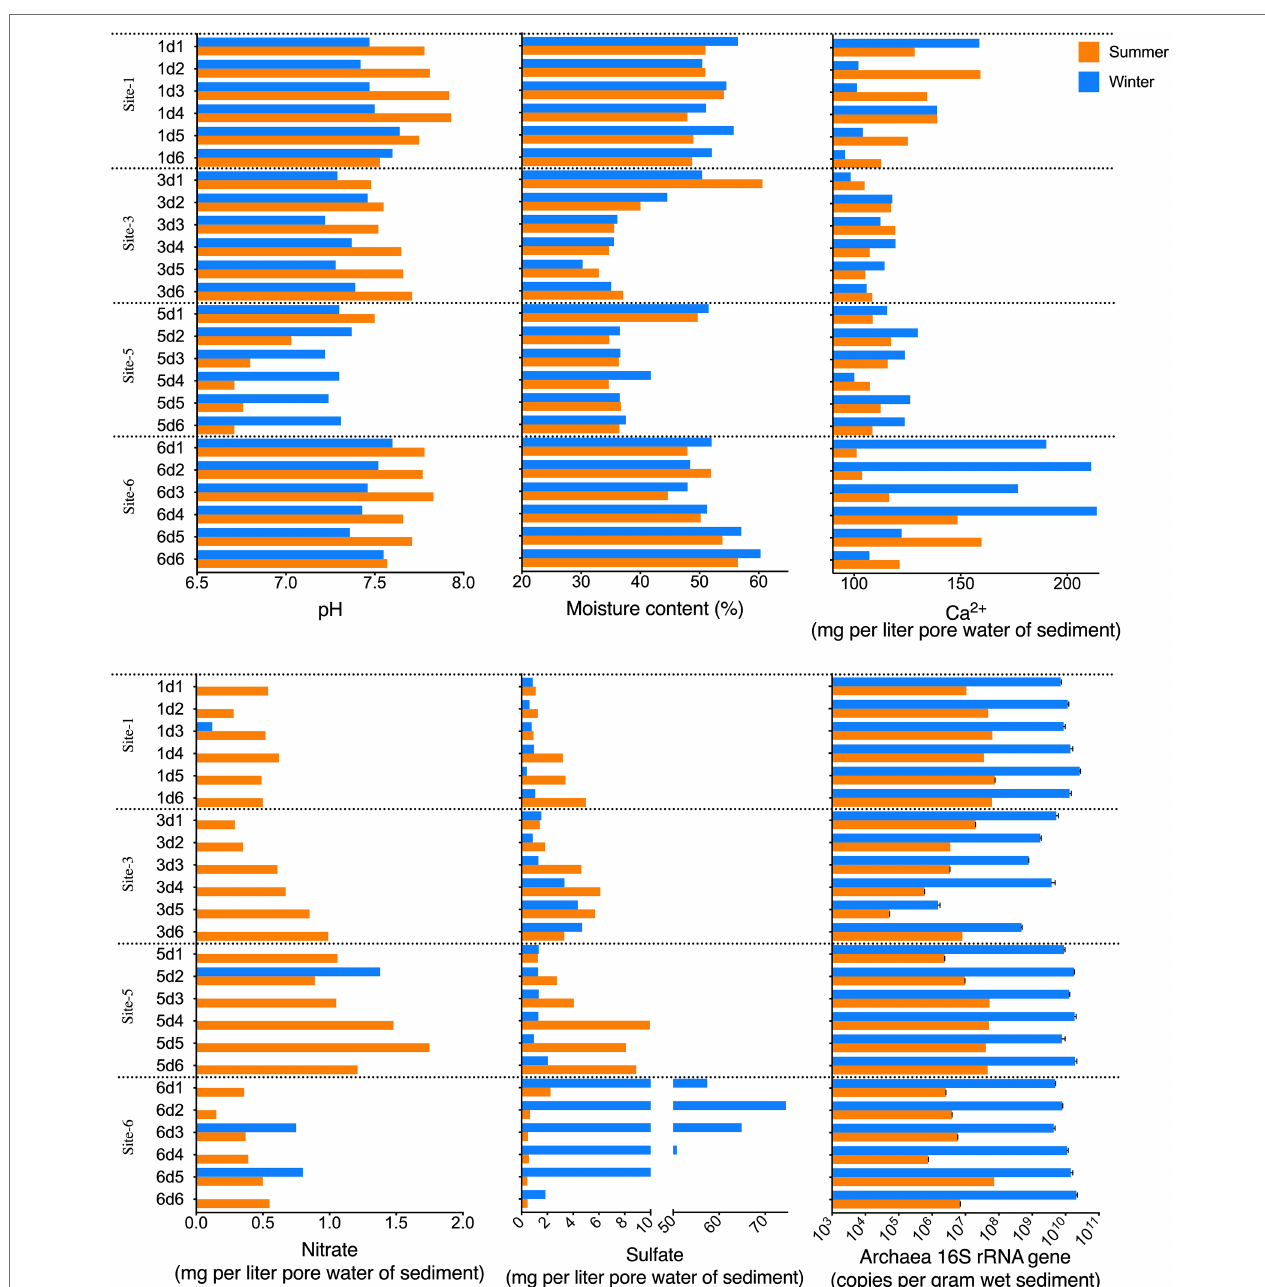
FIGURE 2 | Physicochemical properties (pH, moisture content, and dissolved Ca 2+ , sulfate, and nitrate in the sediment pore water) and archaeal 16S rRNA gene abundance of the sediment